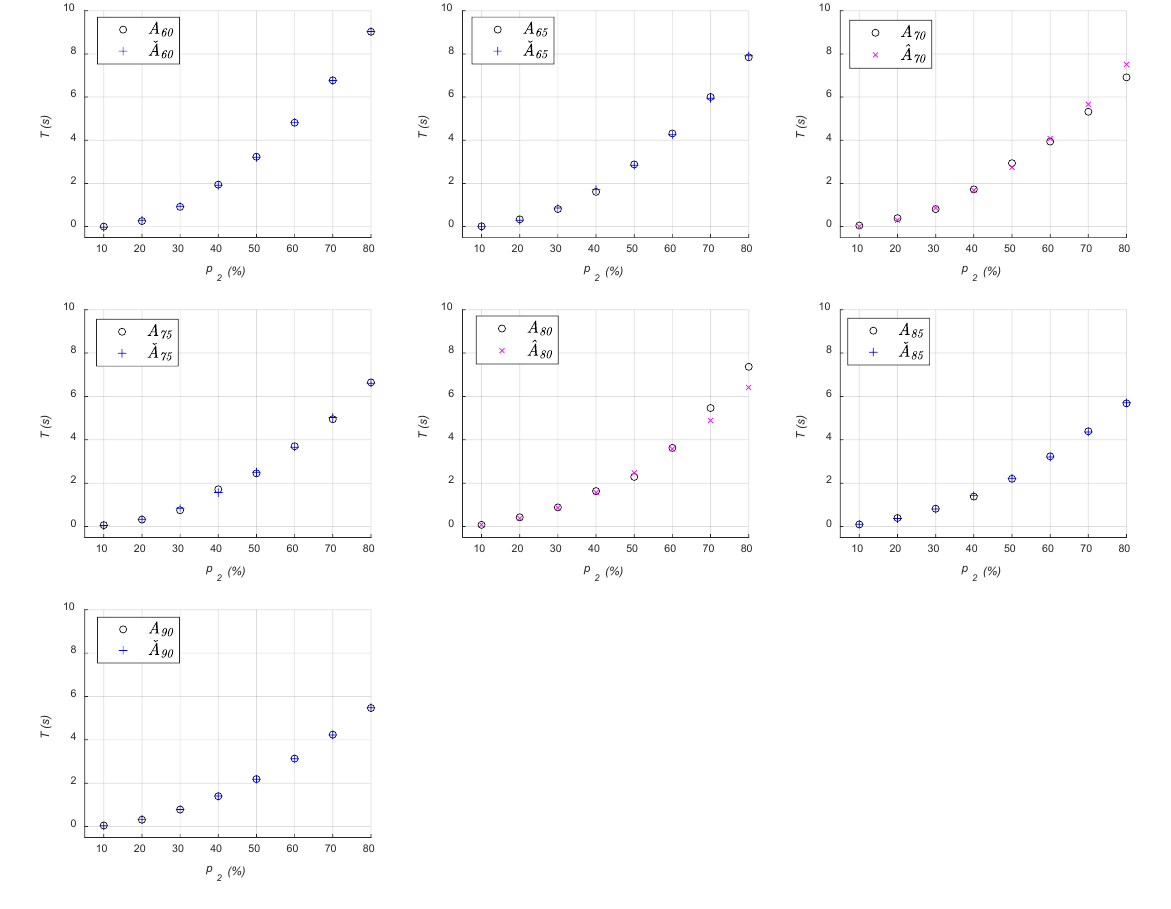
vs. T (procedure 3). Figure 3. p 2 vs. T (procedure 𝑠𝑠 2